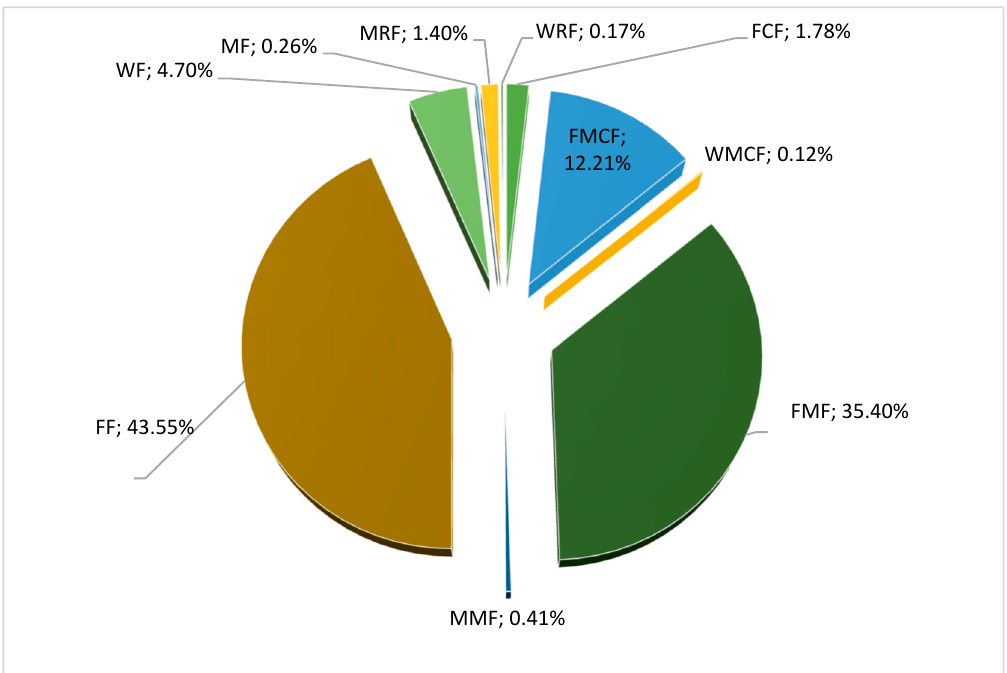
Figure 1. The percentage share of forest habitat types in the research area. Coniferous forests: fresh (FCF); mixed coniferous forests: fresh (FMCF), wet (WMCF); mixed forests: fresh (FMF), marshy (MMF); forests: fresh (FF), wet (WF), marshy (MF), i.e., alder carr. riparian forests: wet (WRF), marshy (MRF), or ash alder (Source: Author’s original compilation).